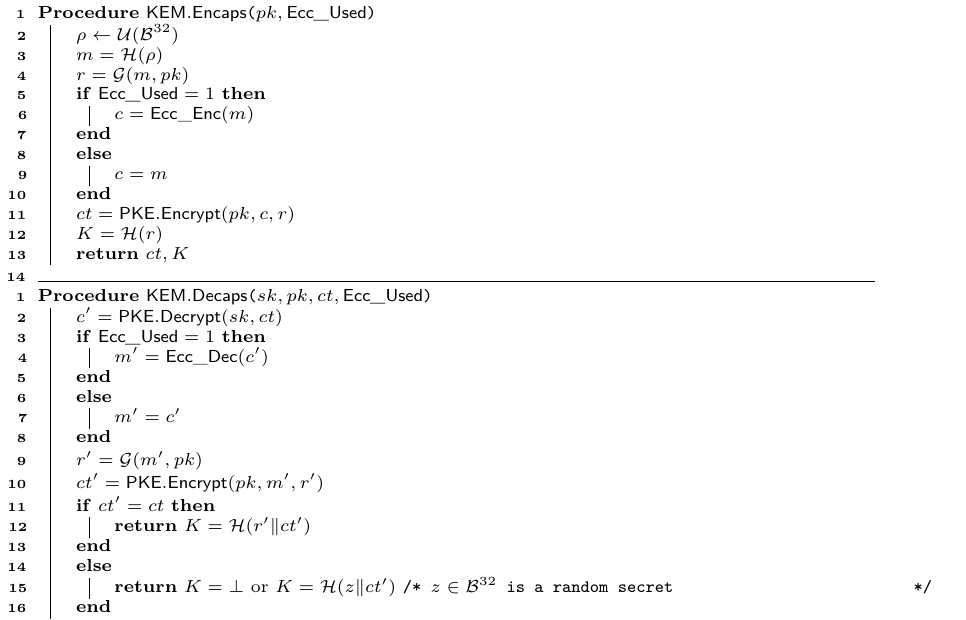
Algorithm 1: FO transform of a IND-CPA secure PKE into a IND-CCA secure